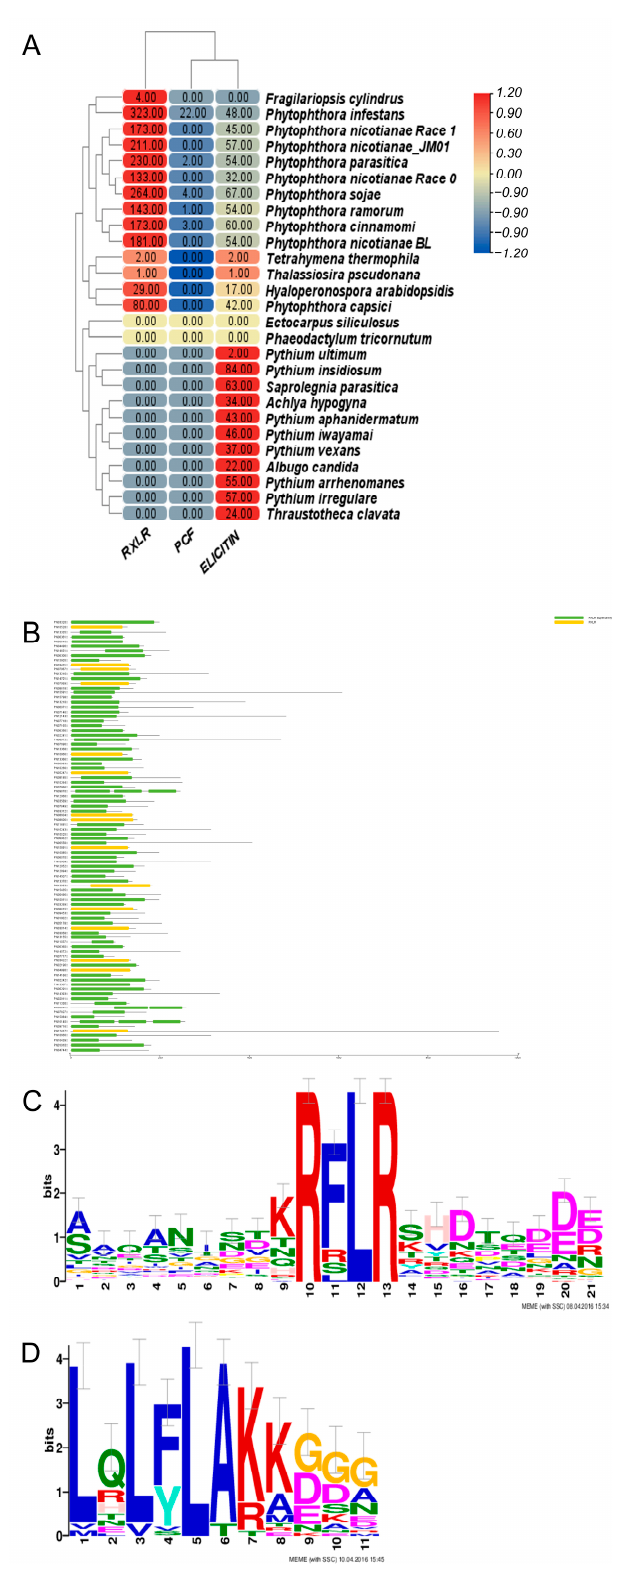
Figure 3. Prediction results of effectors in Ph. nicotianae JM01 genome and other species. ( A ) Results of effectors in the Ph.nicotianae JM01 genome and other species. A heatmap was used to present the gene numbers of RXLR, PCF and ELICITIN; ( B ) Genes structures of RXLR in Ph.nicotianae JM01. Conserved domains were drawn in NCBI; ( C ) Typical architecture of RXLR in Ph. nicotianae JM01; ( D ) Typical architecture of CRN in Ph. nicotianae